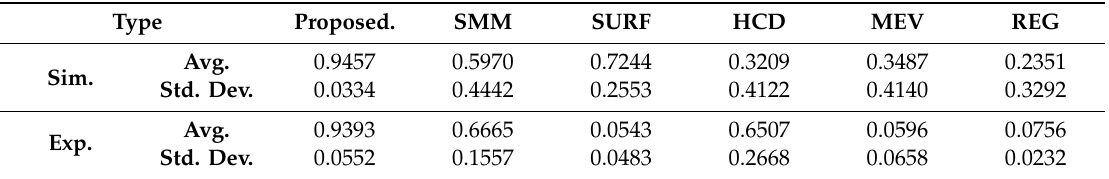
Figure 8. Comparison of matching indices with the proposed method and other methods according to the different pairs of individual maps produced from the whole map in simulations. The matching indices with the proposed method were consistently higher than those with other methods. Table 2. Comparison of the averages and standard deviations of matching indices with di ff erent methods in simulations and experimental